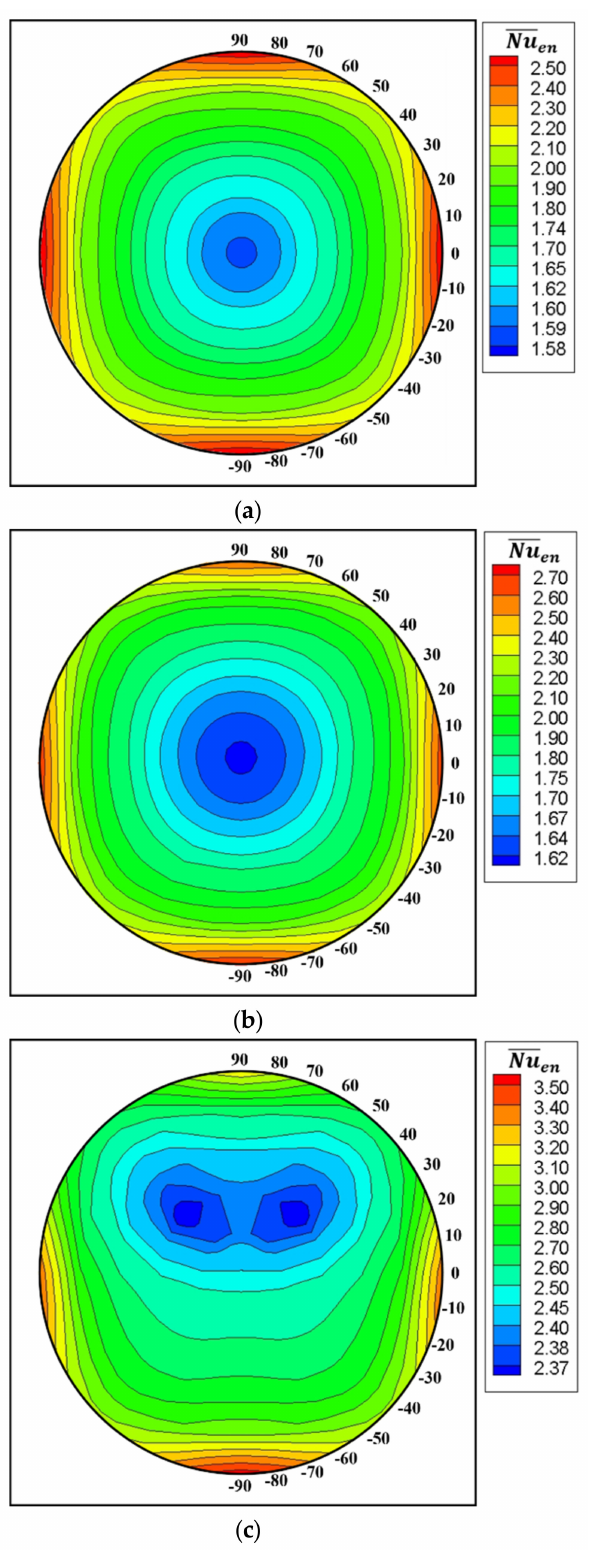
Figure 21. Total surface-averaged Nusselt number of the enclosure for ( a ) Ra = 10 3 , ( b ) Ra = 10 4 and ( c ) Ra = 10 5